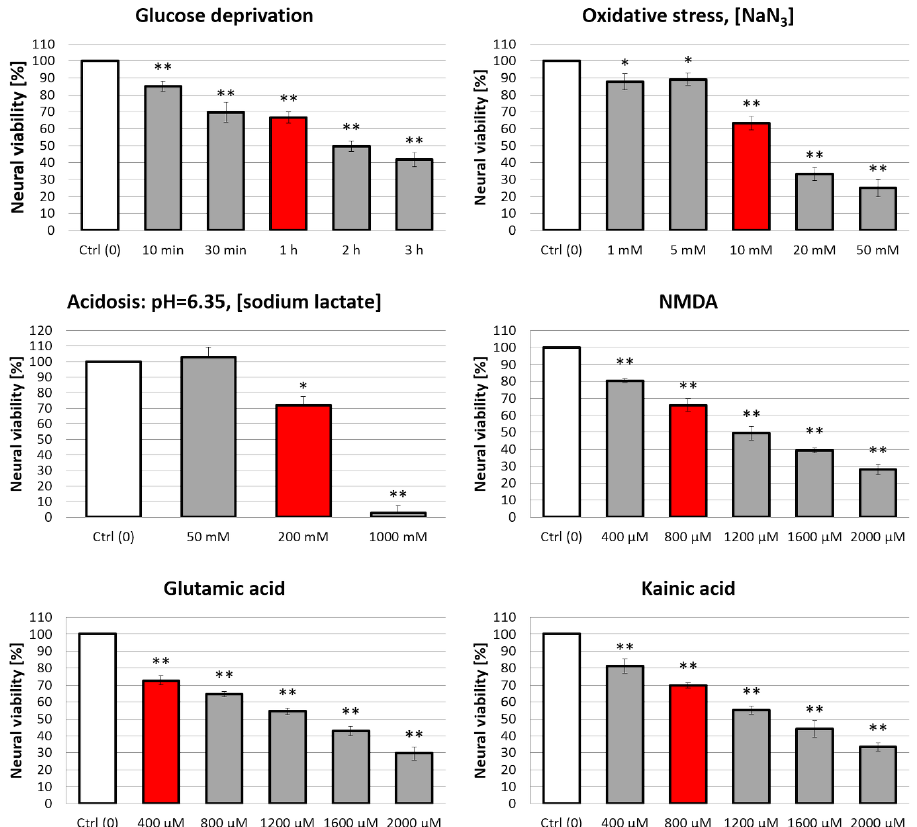
Figure 6. Optimization of an in vitro model of AIS. Red bars indicate conditions causing a 30–40% decrease in neural viability. These conditions were then selected for assessments of the neuroprotective activity of tested peptides. Non-insulted cells were treated as 100% control. Two-way ANOVA statistics: n = 3; * p < 0.05, ** p < 0.001. Each statistical significance asterisk refers to a respective control (white bar) ± SD.